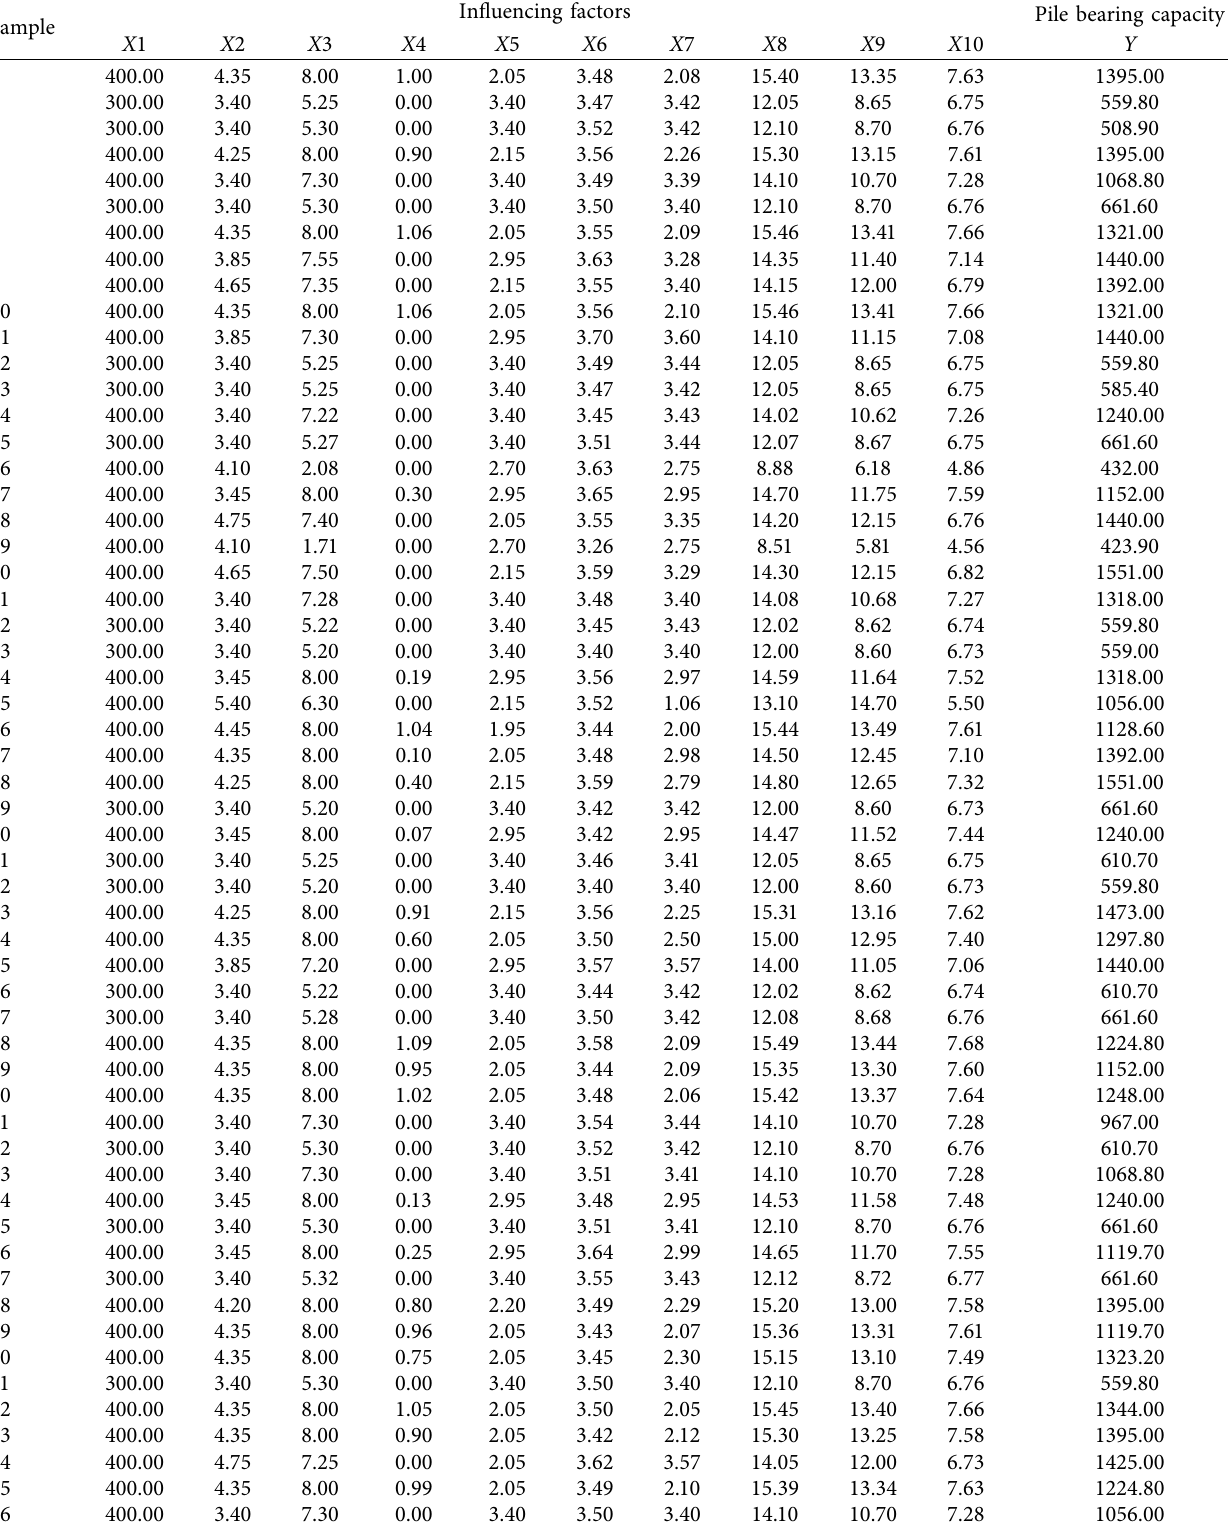
Table 6: The explanatory variables include pile diameter ( X1 ), thickness of the first soil layer ( X2 ), thickness of the second soil layer ( X3 ), thickness of the third soil layer ( X4 ), elevation of the natural ground ( X5 ), top of pile elevation ( X6 ), elevation of the extra segment of pile top ( X7 ), depth of pile tip ( X8 ), mean value of SPT blow count along pile shaft ( X9 ), and mean value of SPT blow count at pile tip ( X10 ). The predicted variable ( Y ) is the axial pile bearing